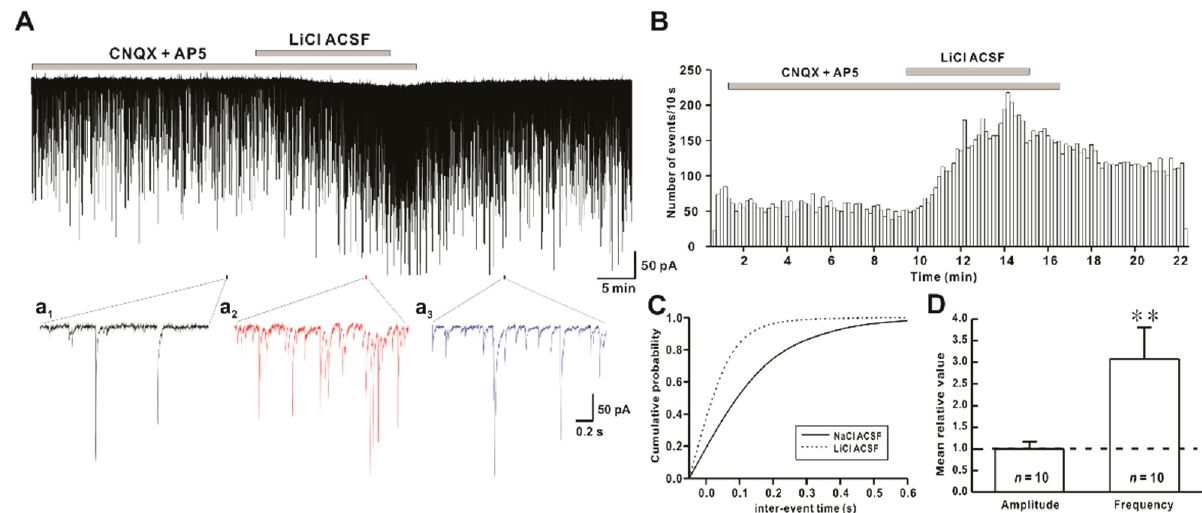
Figure 1. Effect of Li + (126 mM) on spontaneous inhibitory postsynaptic currents (sIPSCs) on hypothalamic preoptic area (hPOA) neurons. ( A ) A representative current trace of sIPSCs recorded in the presence of Na + and Li + artifical cerebrospinal fluid (ACSF) on hPOA neurons at a holding potential of − 60 mV. ( a 1 – a 3 ), sections of the current trace in Figure 1A show sIPSCs before, during, and after perfusion of Li + at 2 s intervals, respectively. ( B ) A spike frequency histogram (bin size 10 s) of current traces in Figure 1A. ( C ) A cumulative probability plot of sIPSCs inter-event interval (IEI) in the presence of Na + (solid line) and Li + (dotted line). Note that the cumulative probability curve was left-shifted by Li + , indicating the increase of sIPSCs frequency (Kolmogorov-Smirnov test, p < 0.05). ( D ) Mean relative amplitude and frequency of sIPSCs in LiCl ACSF compared to NaCl ACSF (** p < 0.01 by a paired t -test).